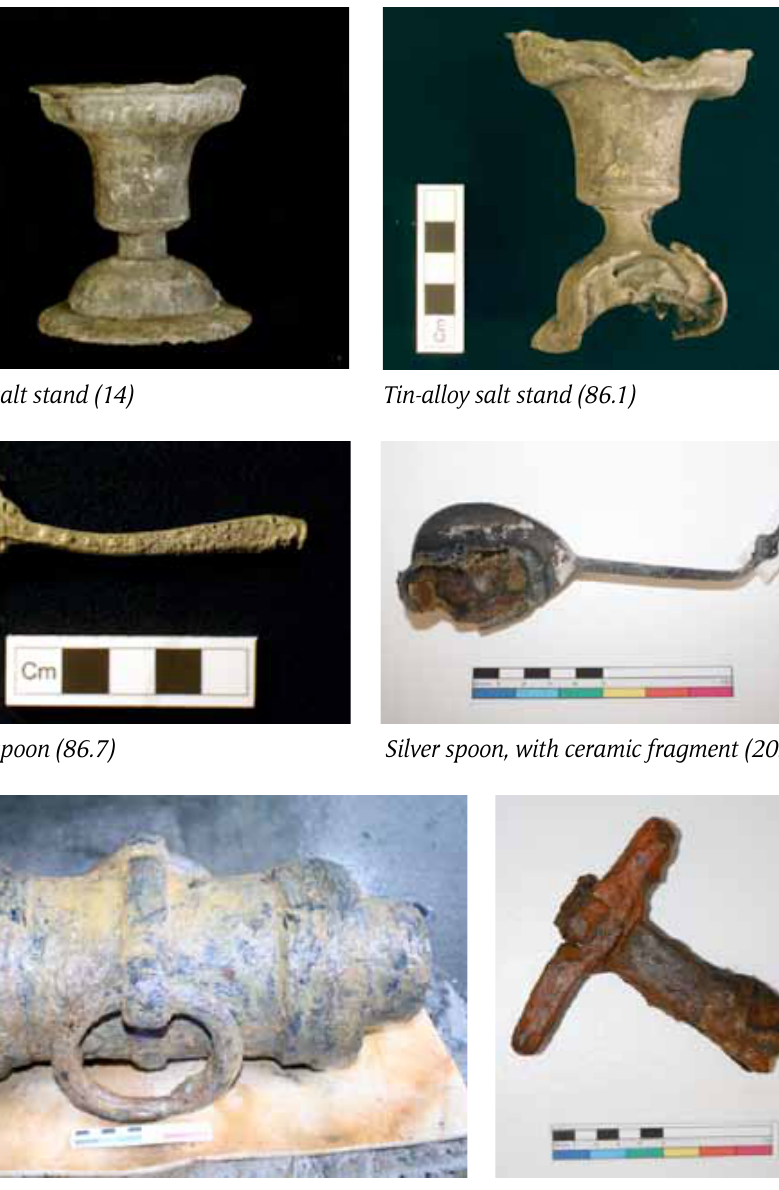
Powder chamber (202.1) Hammer fragment Fig. 2: Selection of finds from the Gresham Ship assemblage.